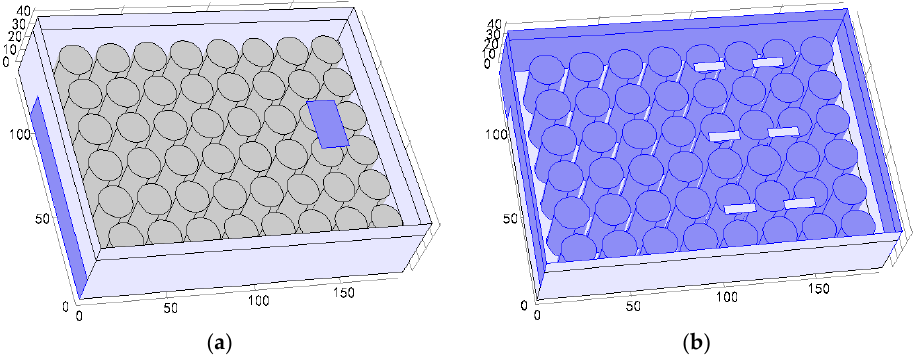
Figure 7. A quarter of the schematic view for the battery pack. ( a ) Two inlets; and ( b ) seven inlets.